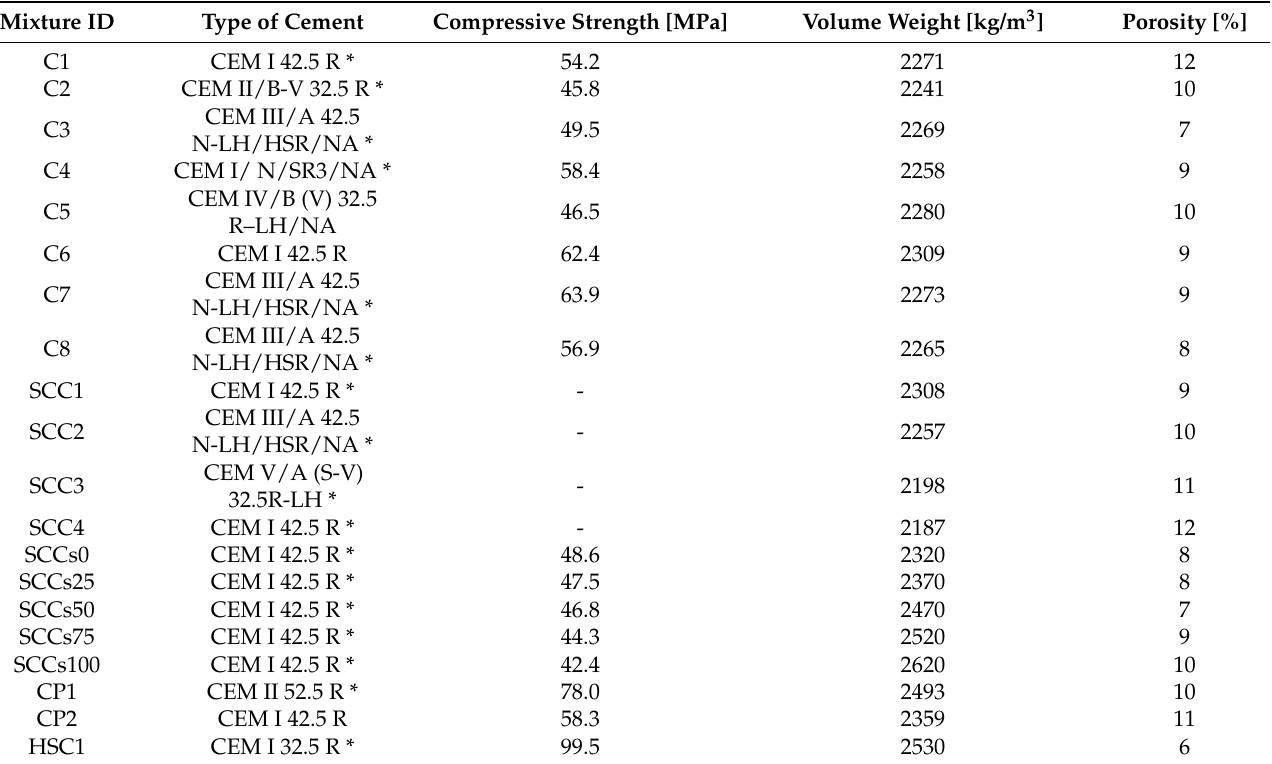
Table 2. Properties and compressive strength of studies concrete mixtures all of the series.